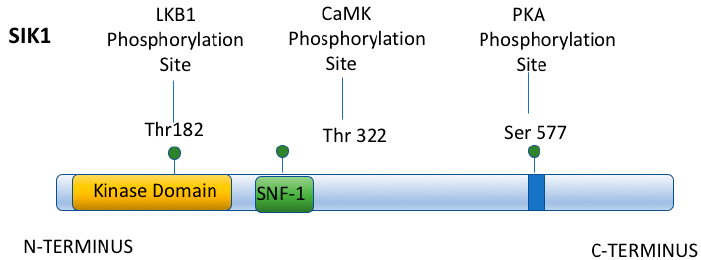
Figure 6. Structure of SIK1. SIK1 has an amino terminal Kinase domain that can be phosphorylated by LKB1, activating SIK1. SIK1 can also be phosphorylated at Thr322 by CaMK and activated. In contrast, SIK1 can be phosphorylated at Ser577 by PKA and inhibited.